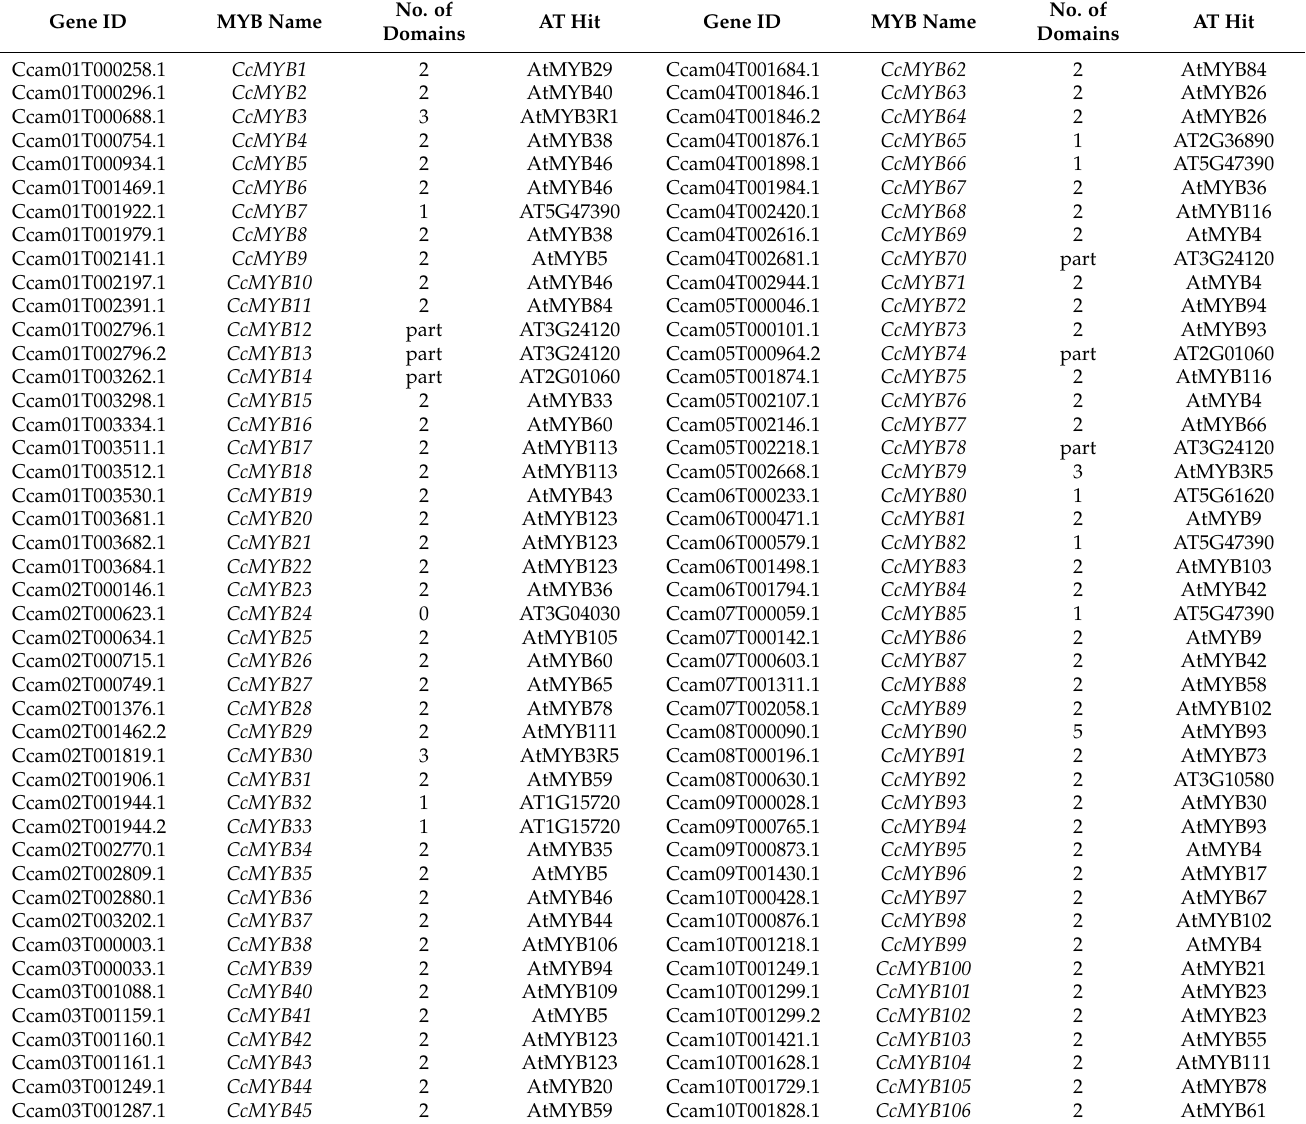
Table 1. Nomenclature and classification of MYB family genes in C. camphora